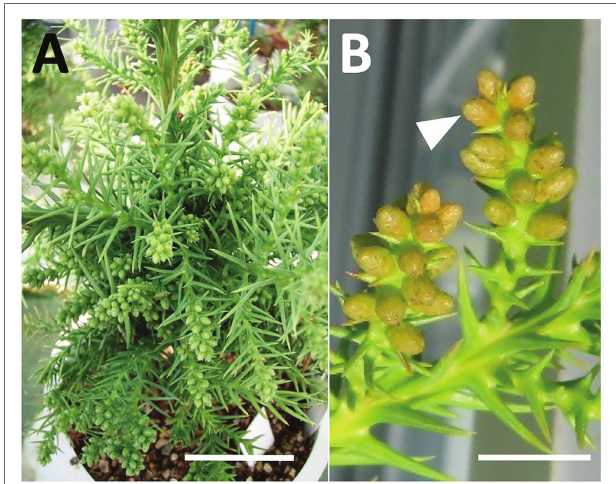
FIGURE 2 | Induction of male flowering in sugi (Japanese cedar, Cryptomeria japonica ) by GA application, (A) male flowering induction 2 months after treatment, (B) male flower development 3 months after treatment (arrow). Bars : 5 cm (A) and 1 cm (B)